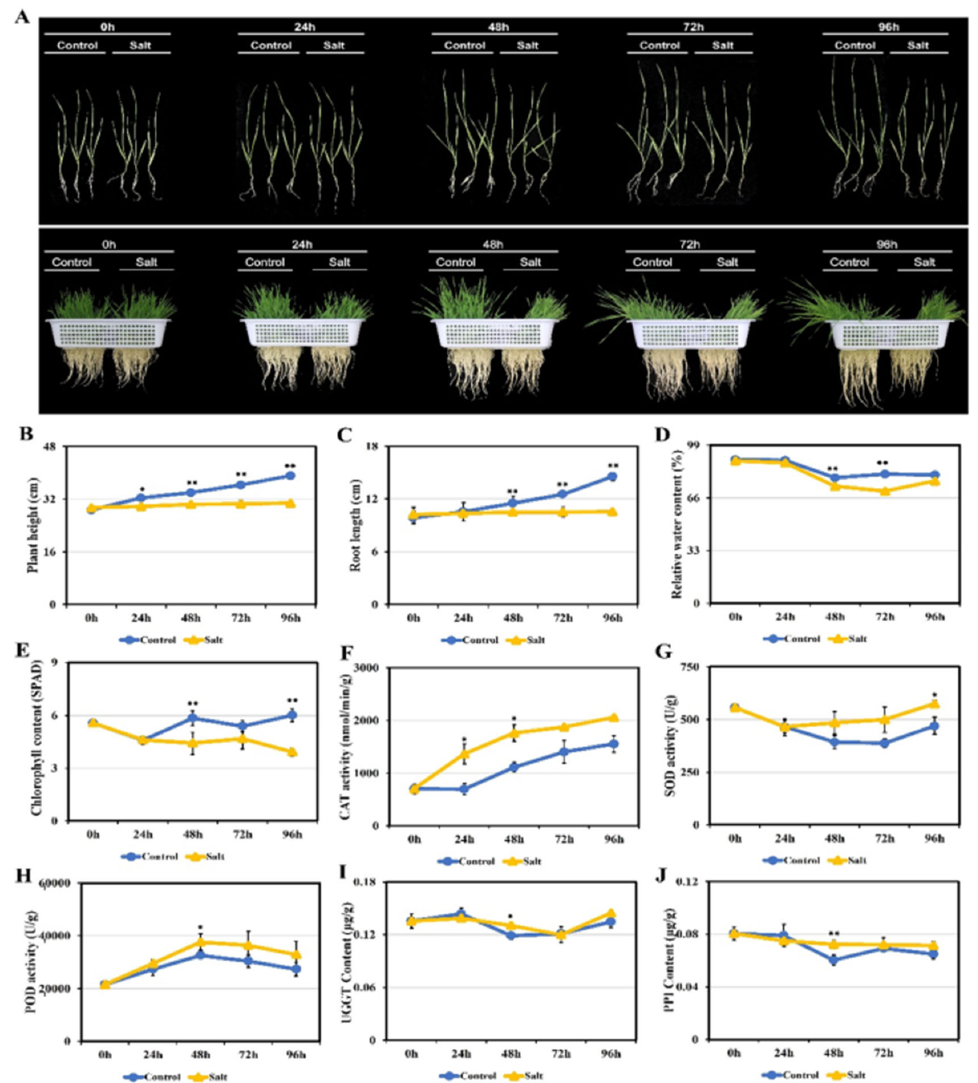
Figure 1. Morphological and physiological changes of wheat cultivar Zhongmai 175 seedling leaves under normal and salt stress conditions. ( A ) Morphology of individual seedling and bunch seedling. ( B ) Plant height. ( C ) Root length. ( D ) Relative water content. ( E ) Chlorophyll content. ( F ) CAT activity. ( G ) SOD activity. ( H ) POD activity. ( I ) UGGT content. ( J ) PPI content. Statistically significant differences were calculated based on an independent Student’s t ‐ test: * p < 0.05; ** p < 0.01.